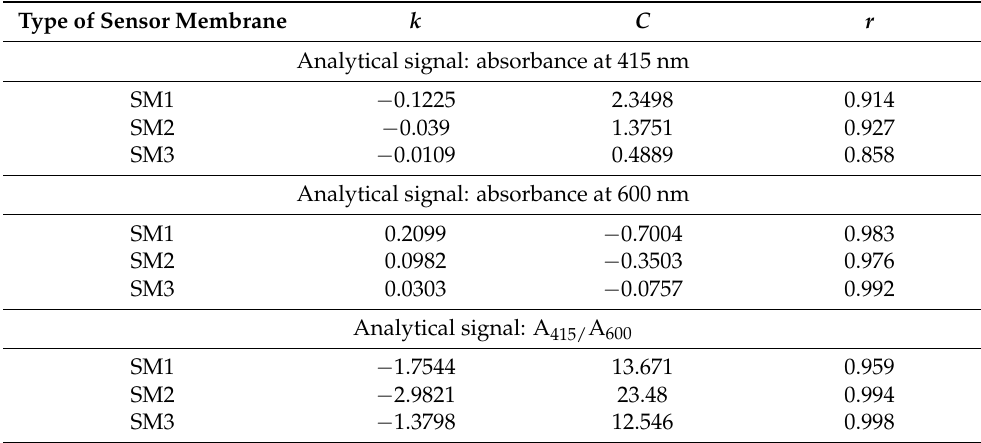
Table 2. Linear response of the analytical signal of the sensor membranes towards milk pH at various detection wavelengths and related correlation coefficients of the linear